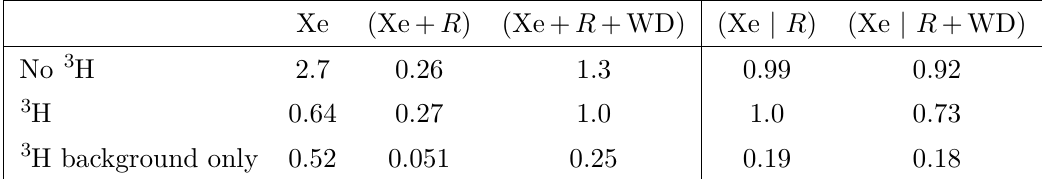
Table 3. Bayes factor in favour of solar ALP versus background, with no tritium background (first row), tritium contributions to the background in both models (second row) and tritium contributions only in the background model (third row). The first three columns show results considering Xe, adding the R parameter and finally adding WD hints. The final two columns show partial Bayes factor for the Xe data given the R parameter, and given the R parameter and WD